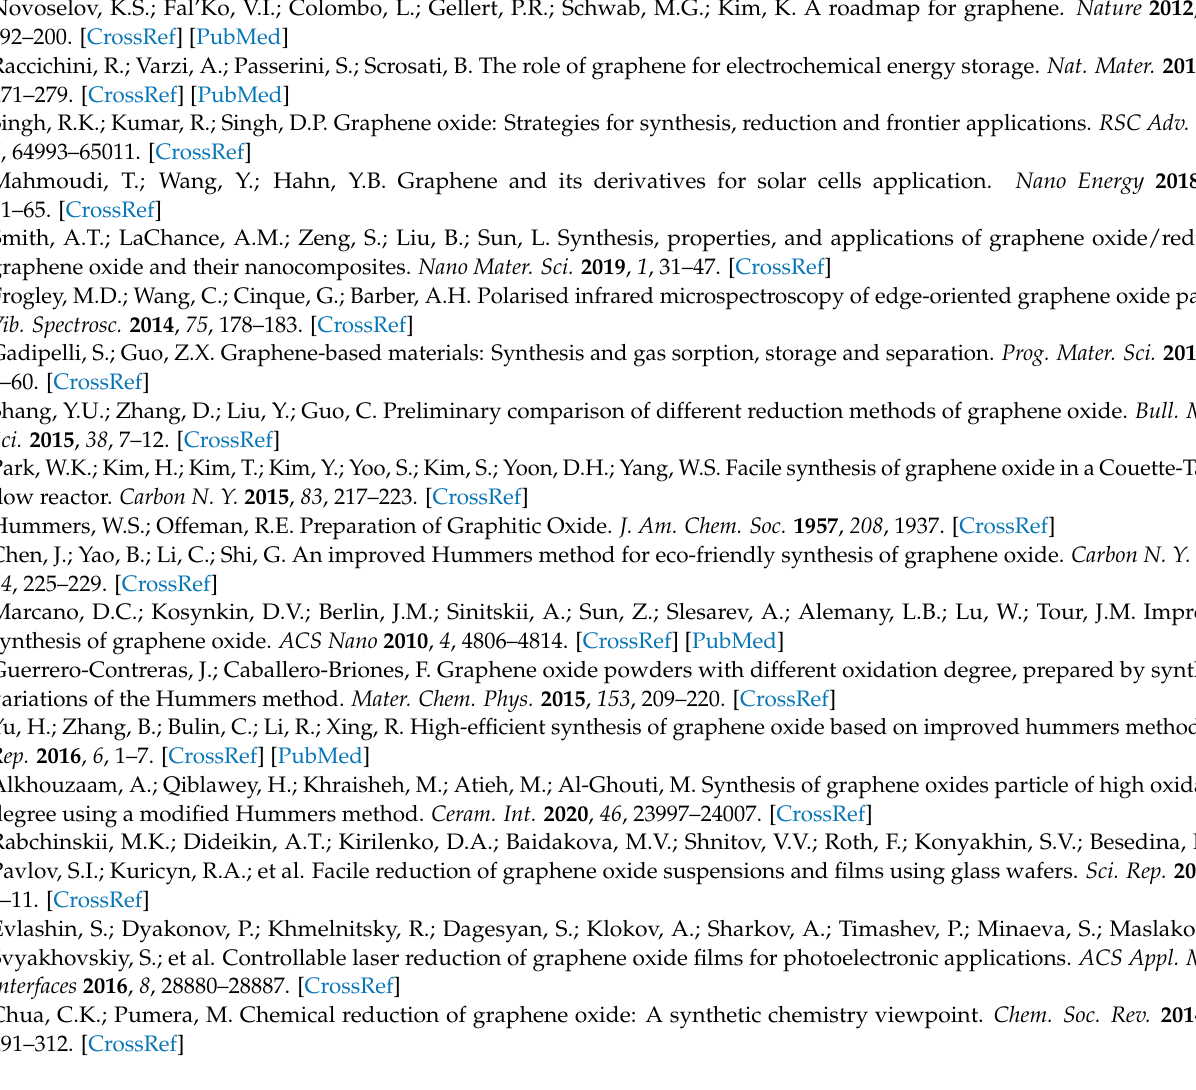
Figure S3: (a) TEM image and (b) HRTEM image of reduced graphene oxide (rGO3), Table S1: Elemental composition of graphene oxide samples, Table S2: Elemental composition of reduced graphene oxide